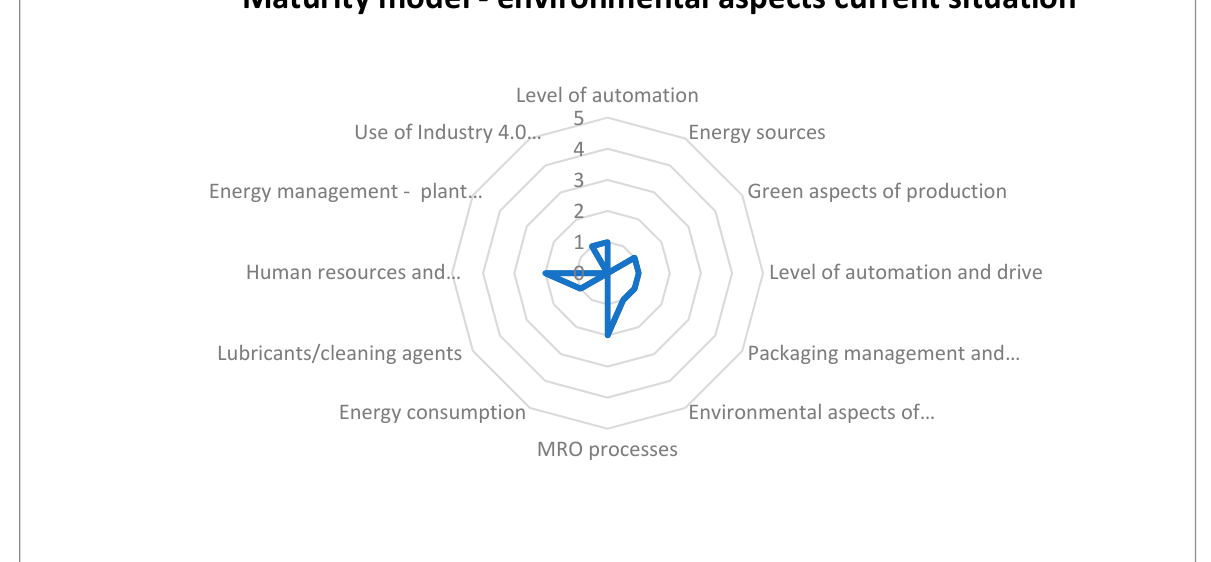
Figure 2. Maturity model–environmental aspects current situation.